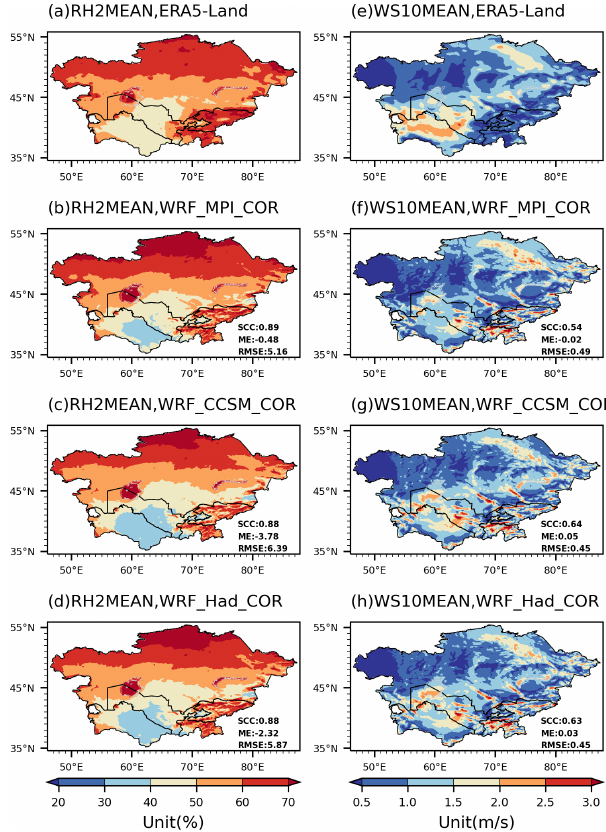
Figure 4. Same as Fig. 3, but for annual mean RH2MEAN and